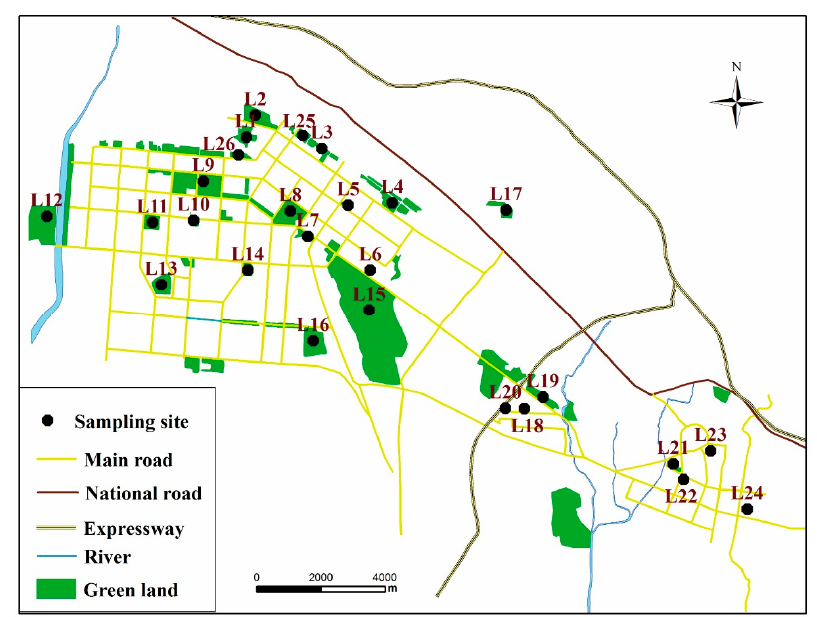
Figure 1. Study area and sampling sites in Baotou, China.